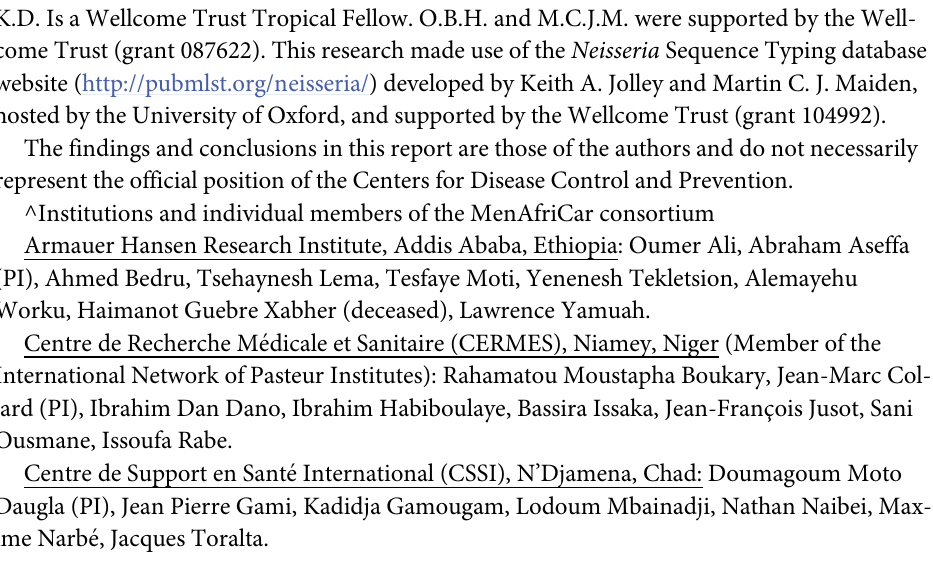
S2 Table. Primer and probe sequences general technical analysis. Results of the BLAST anal- yses performed for each primer and probe using the NCBI BLAST tool. All BLAST results shown were done in the nucleotide collection database, against N . meningitidis (taxon id 487). The Tm and possible dimers were obtained using the primer express design tool. S3 Table. A. Statistical results for gel-based PCR assay. Statistical analysis results of the gel-based PCR assay. Sensitivity, Specificity, Positive Predictive Value (PPV) and Negative Predictive Value (NPV) were assessed for each primers pair in the multiplex and monoplex assay pooling results from test on positive controls (n = 16) and the Malian samples (n = 44) and presented as percent- ages (%). B. Statistical results for the qPCR assay. Statistical analysis results of the qPCR assay. Sen- sitivity, Specificity, Positive Predictive Value (PPV) and Negative Predictive Value (NPV) were assessed for each primers pair in the multiplex and monoplex assay pooling results from test on positive controls (n = 16) and the Malian samples (n = 44) and presented as percentages (%). (DOCX) S1 Dataset. Database used for the analyses for the Chadian Site. (XLSX) S2 Dataset. Database used for the analyses for the Ethiopian Site. (XLSX) S3 Dataset. Database used for the analyses for the Ghanaian Site. (XLSX) S4 Dataset. Database used for the analyses for the Malian Site. (XLSX) S5 Dataset. Database used for the analyses for the Niger Site. (XLSX) S6 Dataset. Database used for the analyses for the Senegalese Site.